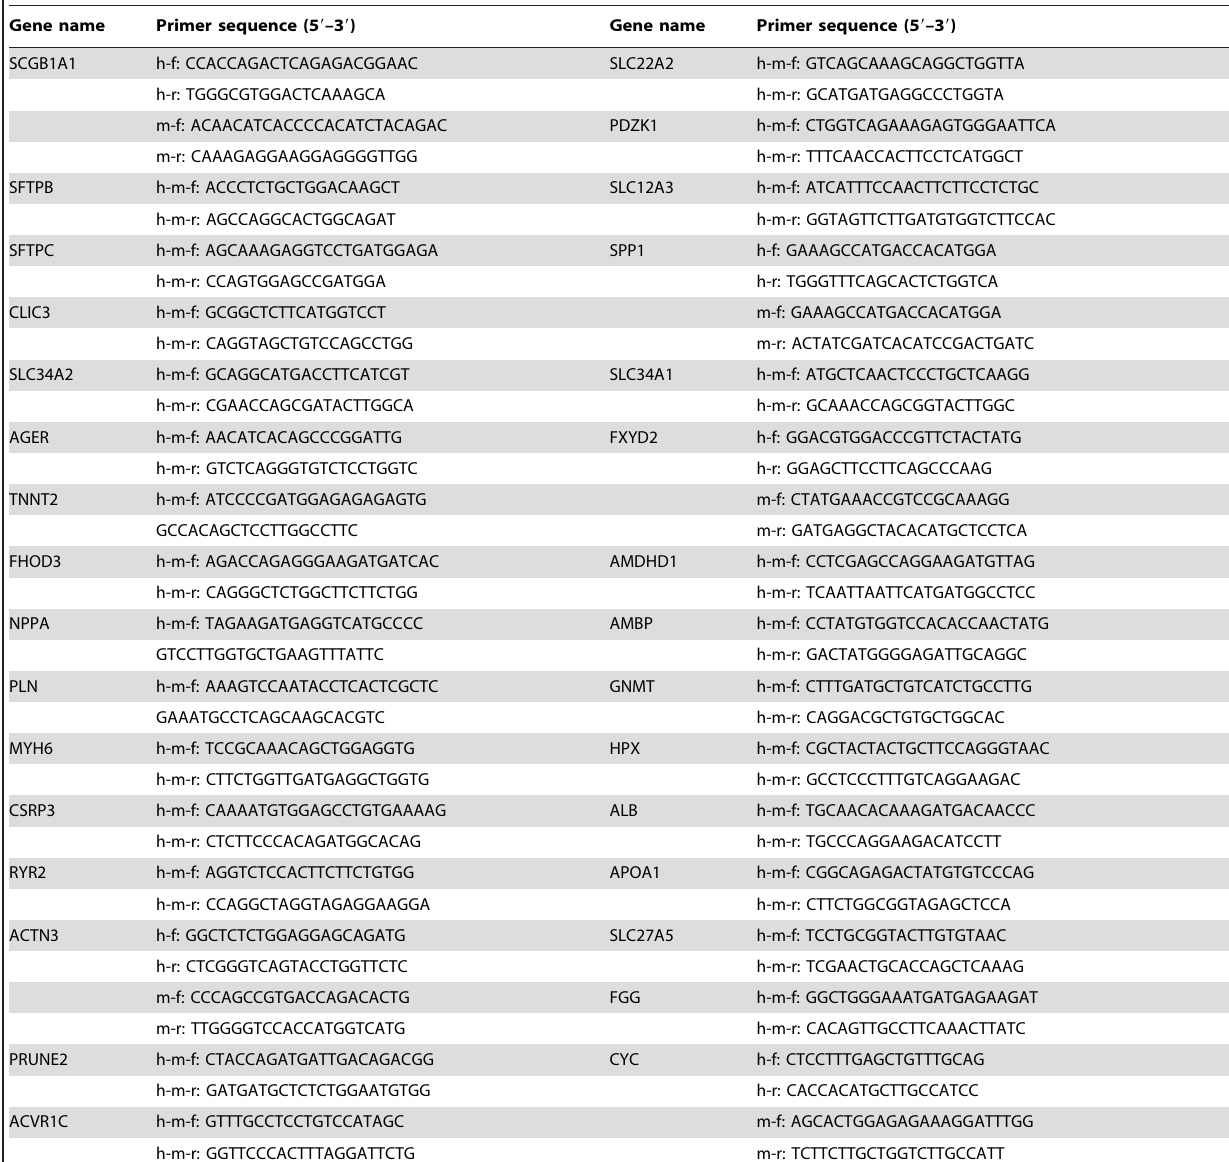
Table 1. Primer sequences for PCR